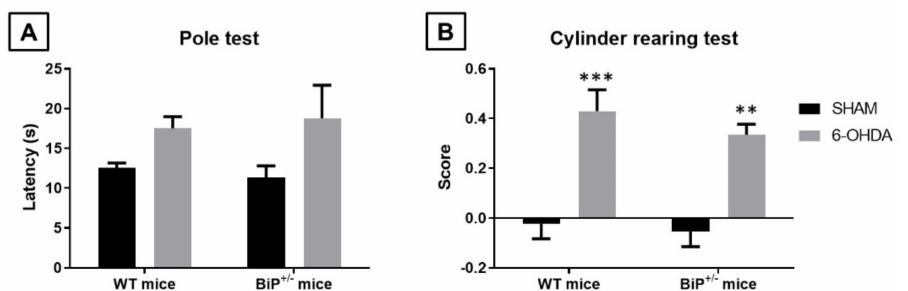
Figure 7. Response in the pole test (panel ( A )) and in the cylinder rearing test (panel ( B )) of wild-type male mice with normal or partial ablation of the BiP protein subjected to unilateral 6-OHDA lesions or sham-operated. Values are means ± SEM of more than 5 animals per group. Data were assessed by two-way ANOVA followed by the Bonferroni test (** p < 0.01, *** p < 0.005 vs. the corresponding sham-operated group).